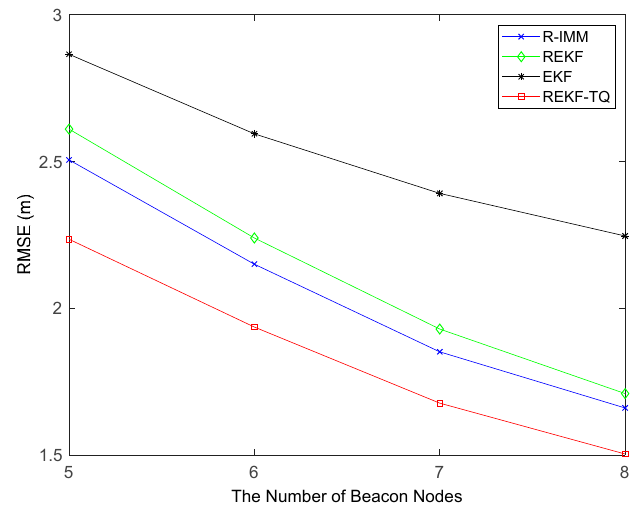
Figure 5. The RMSE versus the number of beacon nodes.